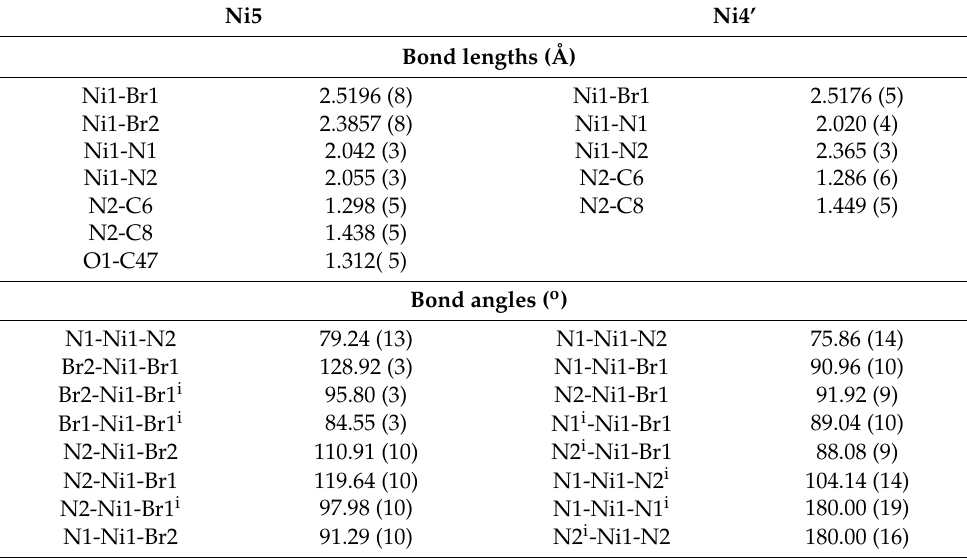
Table 1. Selected bond lengths (Å) and angles ( ◦ ) for Ni5 and Ni4’